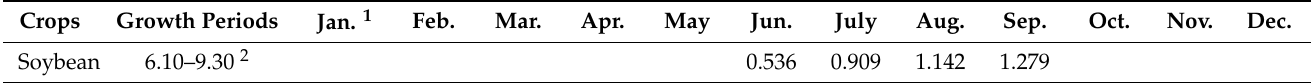
Table 1. Crop factors for soybeans.